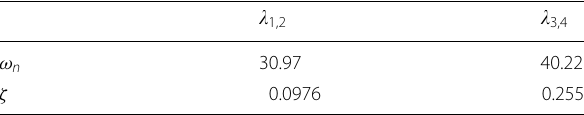
Table 2 Damping ratios and natural frequencies of the 3 DoF unconstrained mechanical